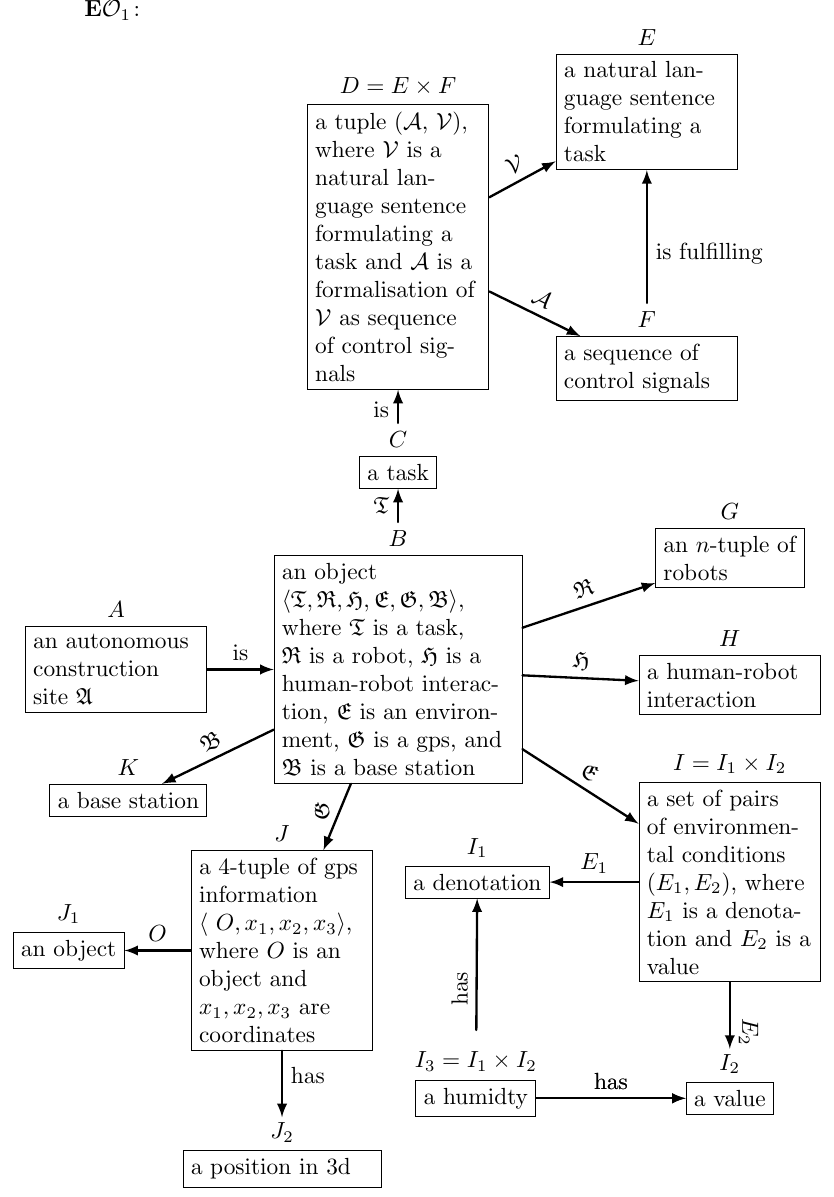
Figure 3. Olog representation of an autonomous construction site after the application of an expansion mapping E